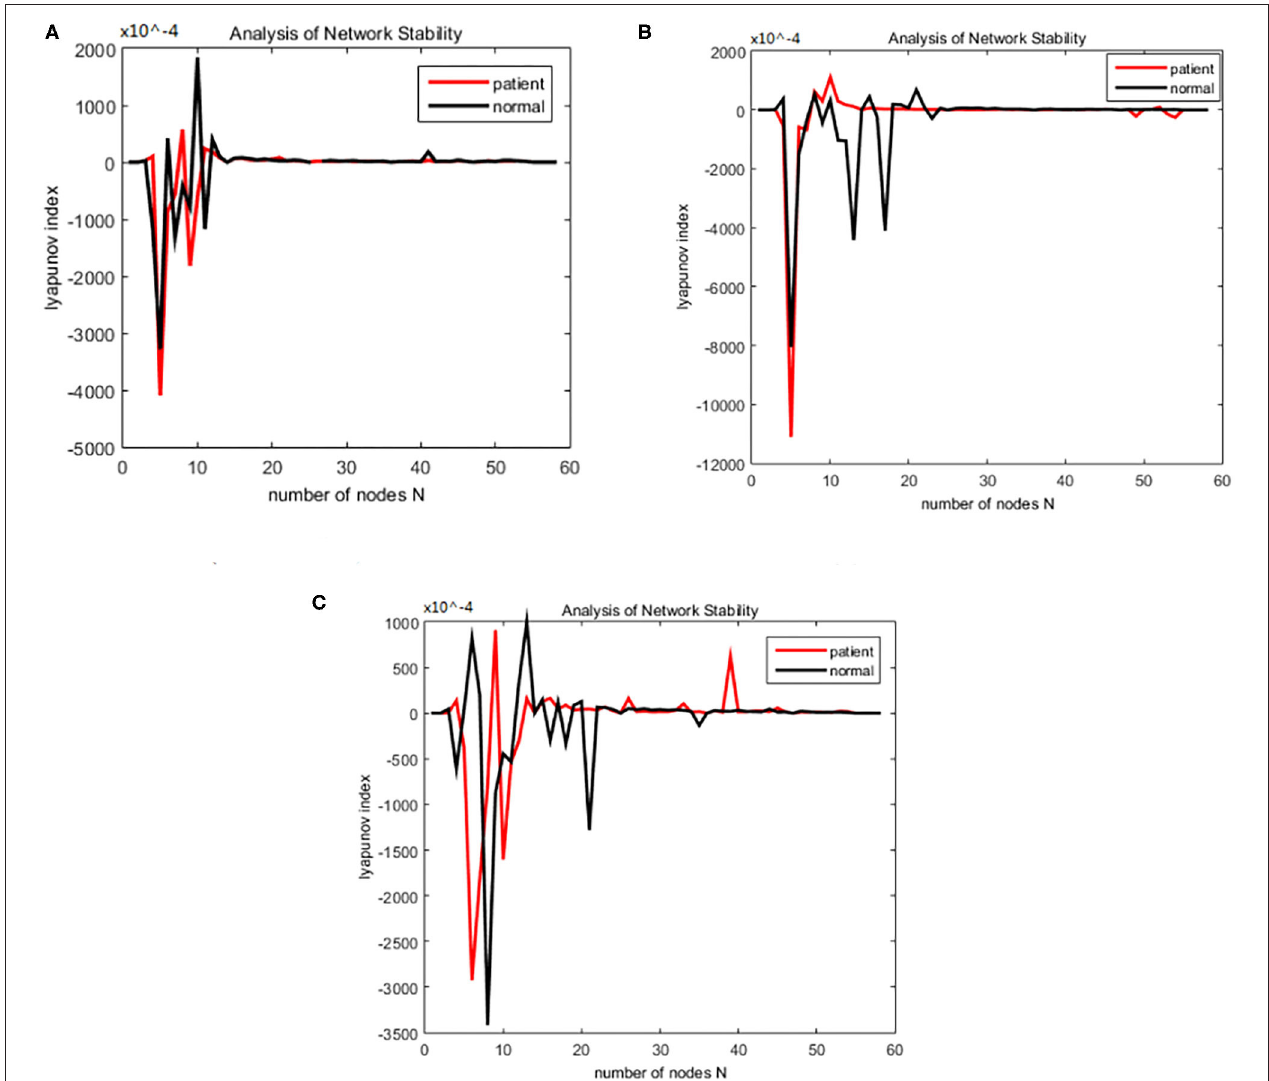
FIGURE 9 | Changes in the Lyapunov exponents during different stages. (A) Encoding stage, (B) maintenance stage, (C) retrieval stage.